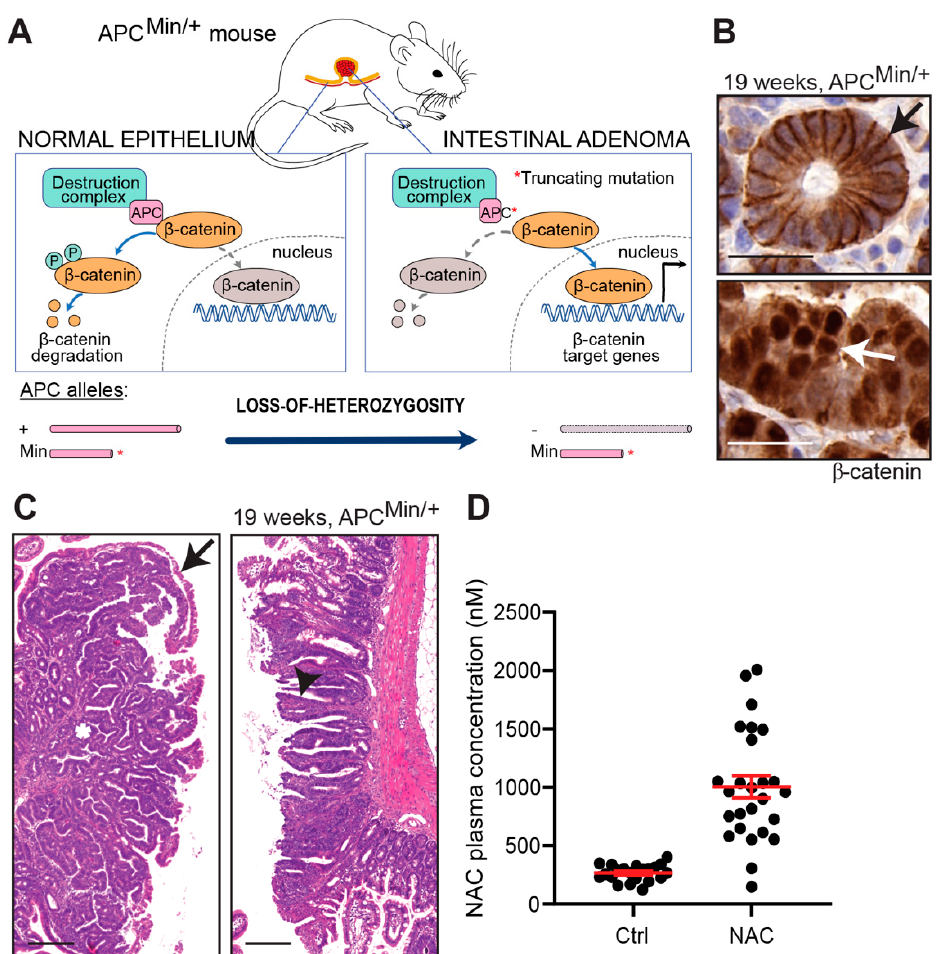
Figure 1. N-acetylcysteine (NAC) levels in the ApcMin model. ( A ) Schematic showing how mutant APC protein (after loss of the second Apc allele) cripples the destruction complex and thus abolishes phosphorylation and subsequent degradation of β -catenin. Instead, unphosphorylated β -catenin translocates to the nucleus and activates the transcription of β -catenin target genes. ( B ) Photomicrographs showing β -catenin staining in plasma membranes of normal epithelial cells (top panel, black arrow) and nuclear β -catenin staining of tumor cells (bottom panel, white arrow). ( C ) Adenomas with tubular (left) or tubulovillous (right) architecture. Asterisk indicates crypt, white arrow indicates villous, and black arrow indicates a thin layer of normal epithelium that covers tubular adenomas in a manner typical for the model. ( D ) Plasma concentrations of NAC in adult APC Min/+ mice 14 days after treatment start ( n = 21 and 26, respectively). Scale bars are 25 µm in ( B ) and 100 µm in ( C ); error bars indicate SEM.